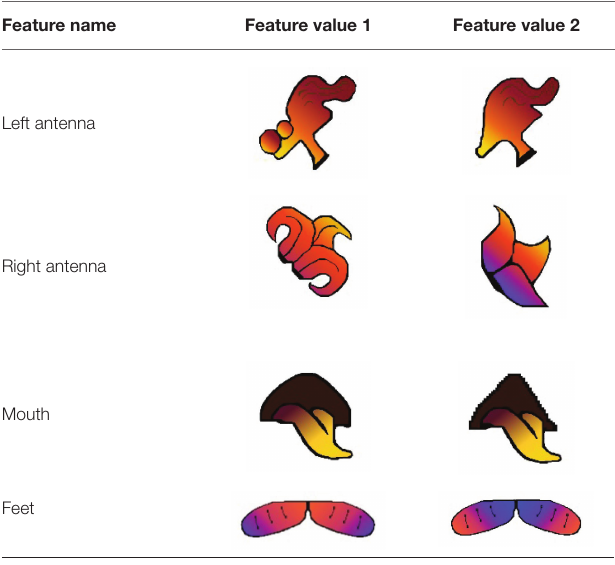
TABLE 1 | Features with feature